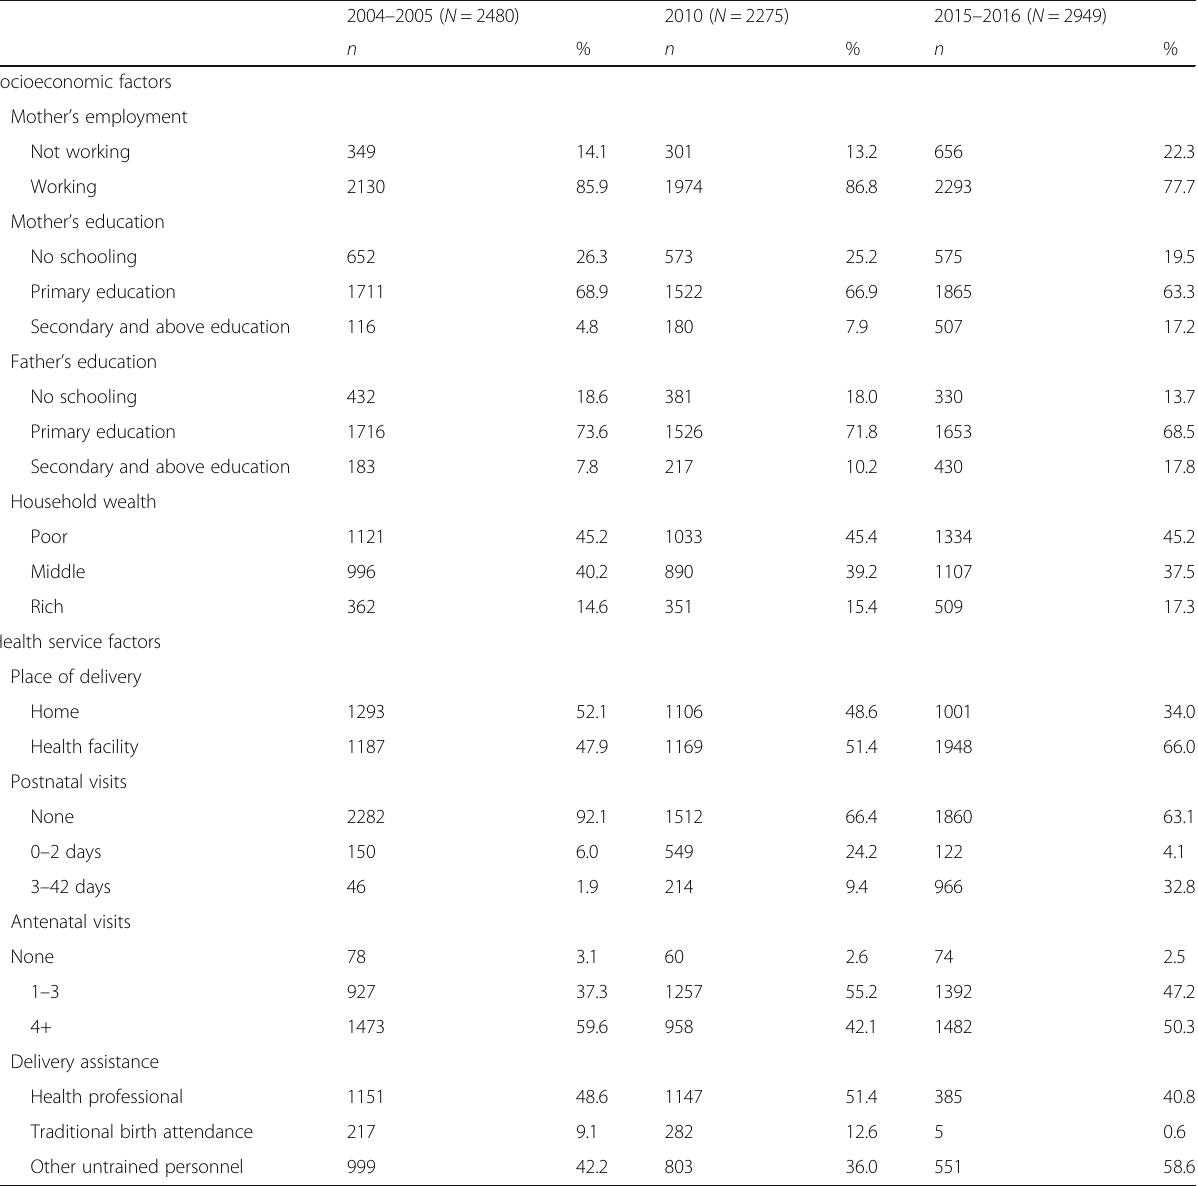
Table 1 Characteristics of the study